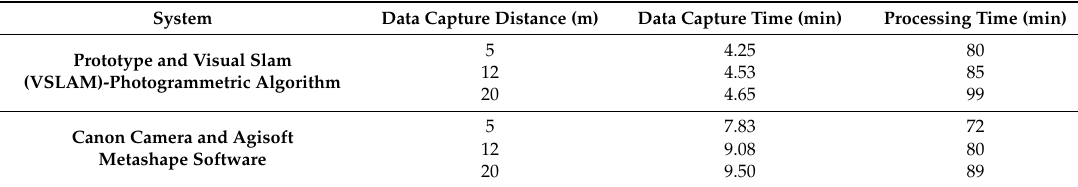
Table 4. Comparison between the proposed approach and the camera with Agisoft Metashape software in regards to the time spent in the field for data capture and processing time using the same laptop (Intel core i7 7700 HQ CPU processor, 16Gb RAM, Operative System Windows 10 Home). Distance values are measured from the camera to the